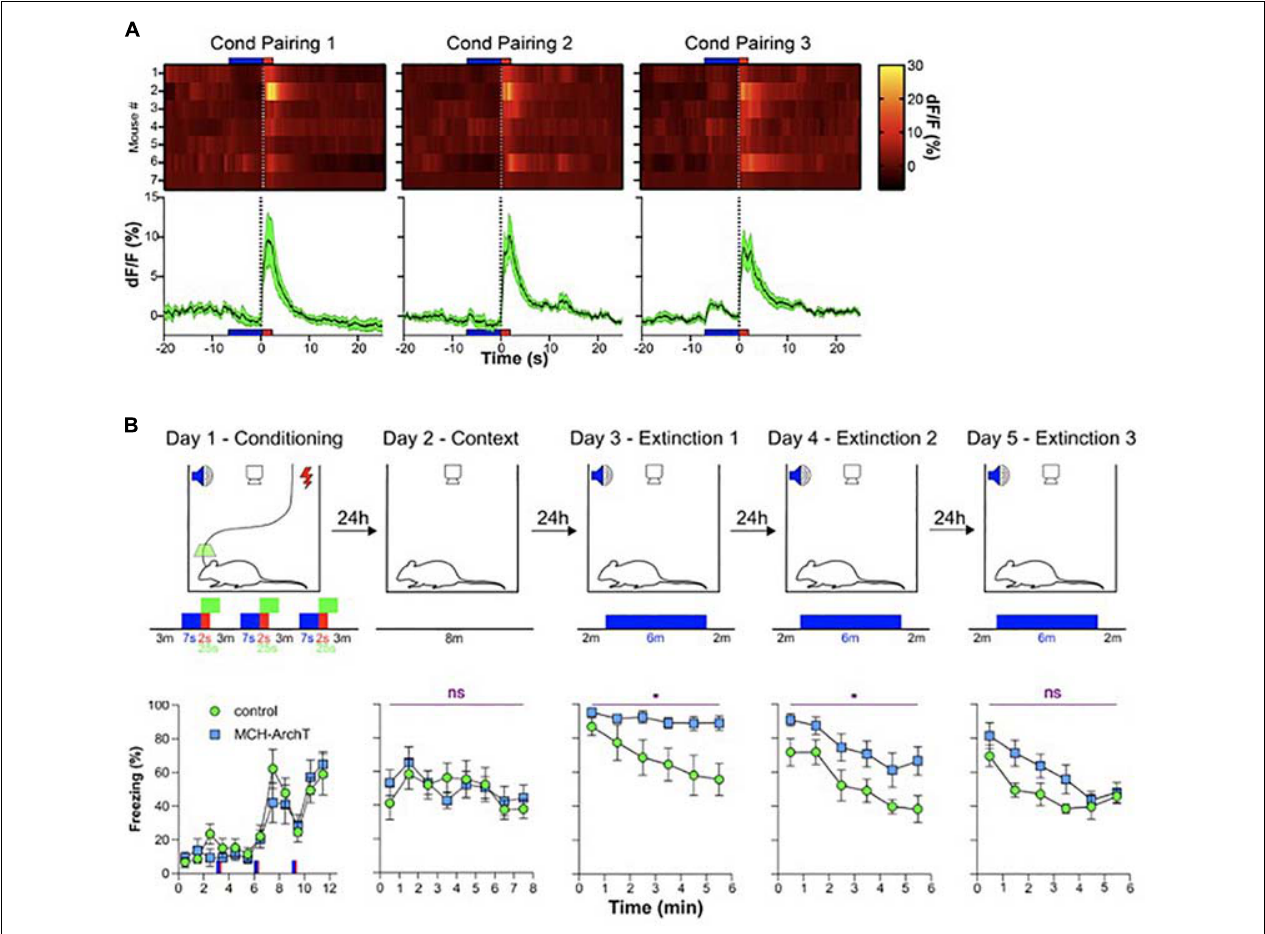
FIGURE 4 | Role of MCH neuron activity during fear conditioning in cued fear extinction. (A) MCH-GCaMP population dynamics during auditory fear conditioning (blue, tone; red, footshock). (B) Effect of MCH-GCaMP cell silencing during conditioning (green squares) on subsequent cued fear extinction, Top row, schematic of experiment; Bottom row, corresponding fear behavior. Source: Concetti et al. (2020). * p < 0 . 05; ns, p ≥ 0 .